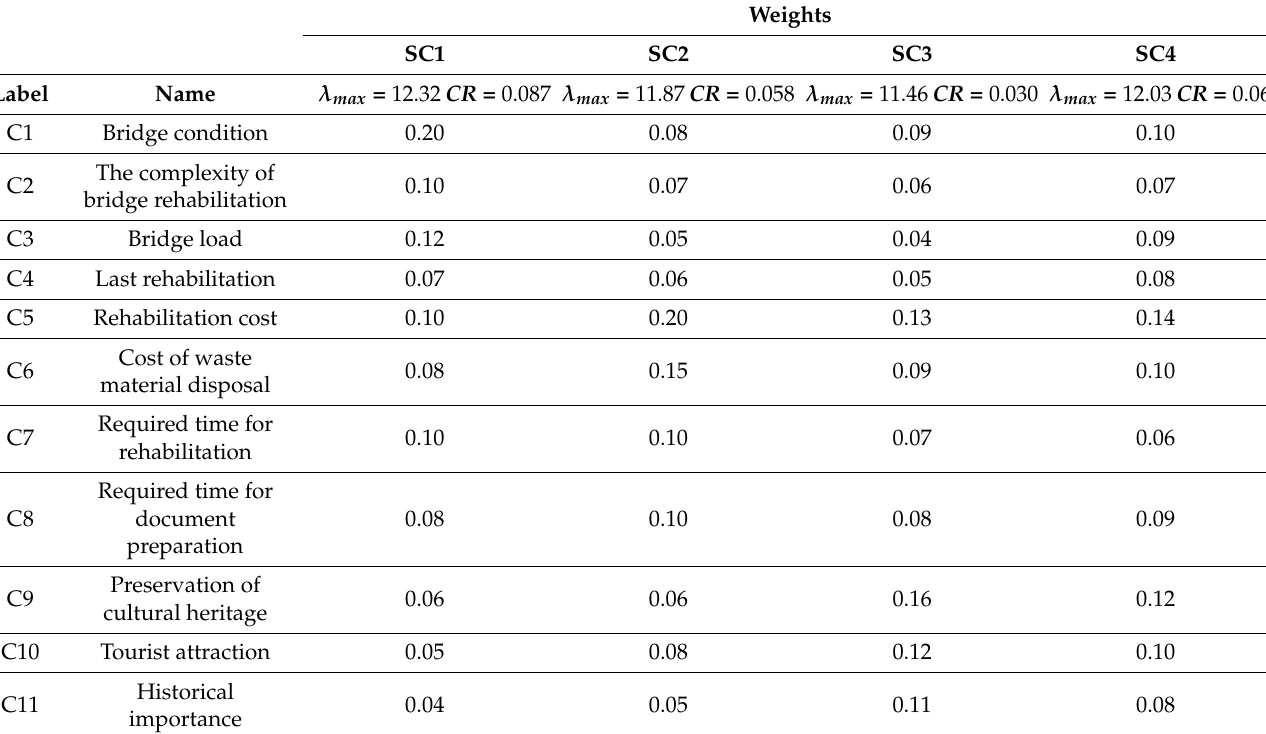
Table 2. Criteria weights by three scenarios and compromise scenario.